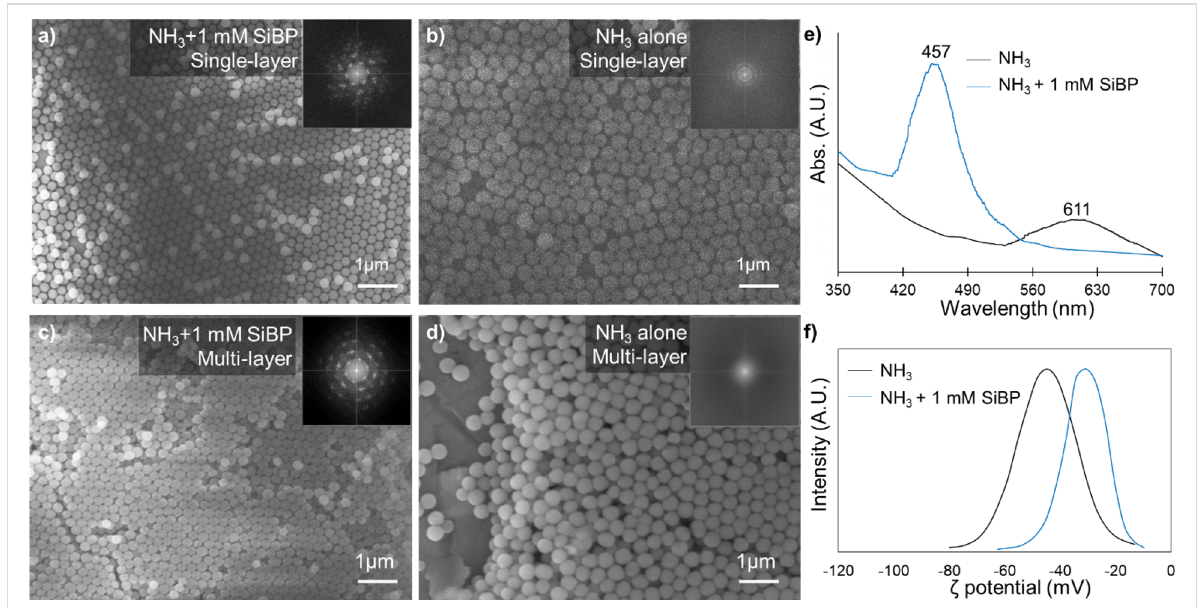
Figure 5: SEM micrographs of (a, c) single-layer and (b, d) multilayer self-assembled SiO 2 particles (insets: corresponding fast Fourier transform diffraction pattern of the images). (e) UV–vis spectrogram of the self-assembled particles on a quartz surface. (f) Zeta potential of the particles in de- ionized water in the presence and absence of the